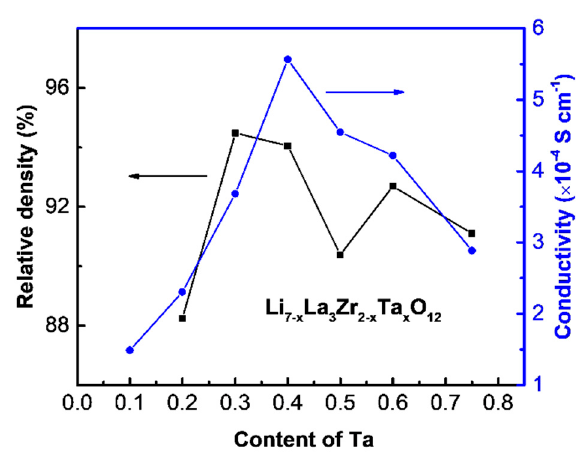
Figure 2. Relative density and ionic conductivity of LLZTO sintering pellets of various components.